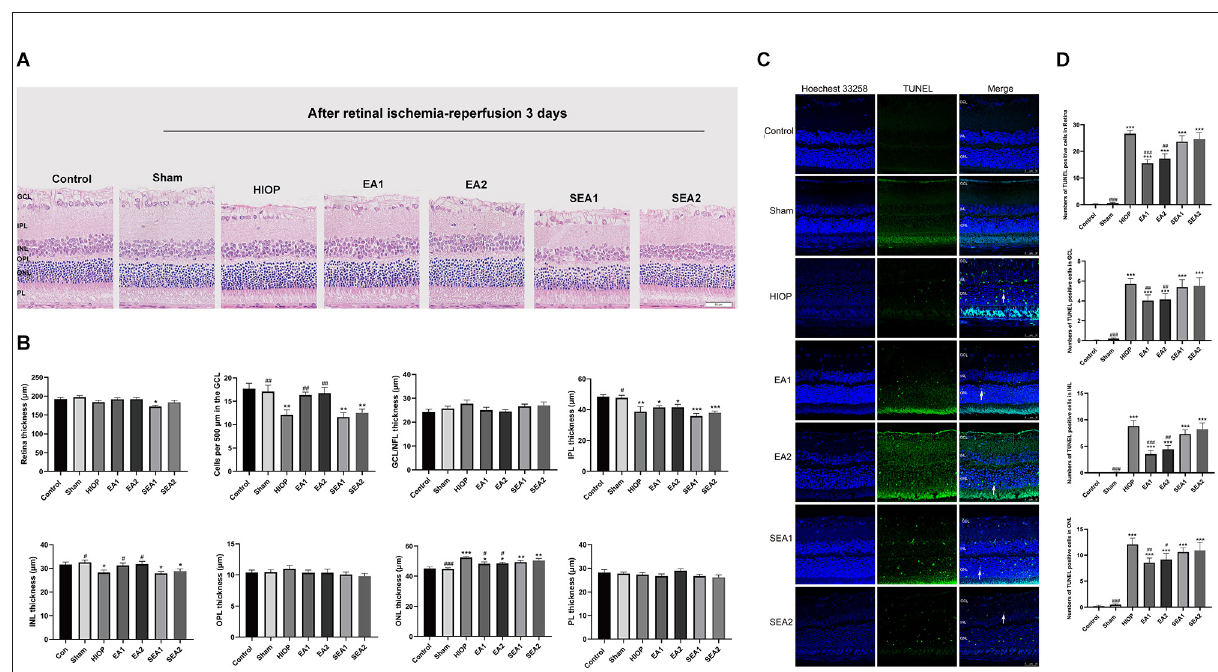
FIGURE5 EA can ameliorate injury and apoptosis of the retina after RIRI for 3 days in rats. (A) H&E staining of retinal cross-sections showing the retinal tissue thickness of every group of ischemia-reperfusion (I/R) rats at 3 days of reperfusion. GCL, ganglion cell layer; INL, inner nuclear layer; IPL, inner plexiform layer; ONL, outer nuclear layer; OPL, outer plexiform layer; PL, photoreceptor layer (scale bar: 50 µ m). (B) Measurement of retinal thickness from the ganglion cell layer (GCL) to the photoreceptor layer (PL); the number of cells per 500 µ m in the GCL and the mean thickness of different retinal layers after RIRI for 3 days in rats are shown. (C) Apoptotic cells were detected by TUNEL assay in retinal sections at 3 days of ischemia-reperfusion injury in rats. Representative images of TUNEL-positive cells (green) are shown. The nuclei were counterstained with Hoechst 33342 (blue). Scale bar: 50 µ m. (D) Bar graphs showing the average numbers of TUNEL-positive cells in the GCL, ONL, INL, and entire retina. The data are presented as the mean ± SEM (* P < 0.05, ** P < 0.01, *** P < 0.001 vs. the control group; # p < 0.05, ## P < 0.01, ### P < 0.001 vs. the HIOP group; n = 5 for each